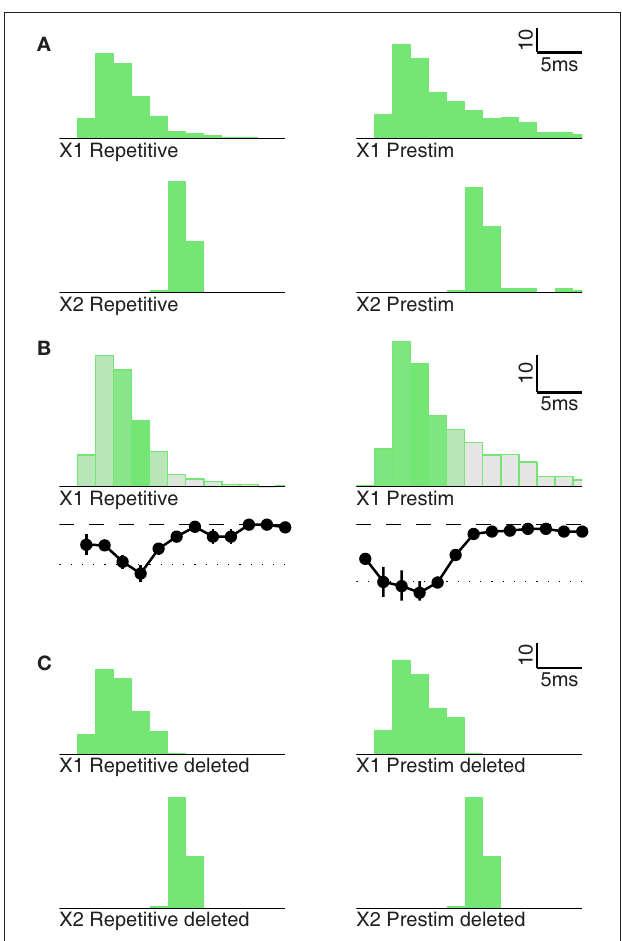
Figure 5 | X2 gain depends on X1 packet shape. (A) Population responses for X1 (top) and X2 (bottom) for repetitive (left) and single post-stimulus inhibition (right). (B) Impact of individual spikes of the X1 response. Shading and the curve below the PSTH indicate the X2 response after deletion of spikes in the corresponding bin. (C) Same as (A) , but after deleting all spikes that did not strongly contribute to the X2